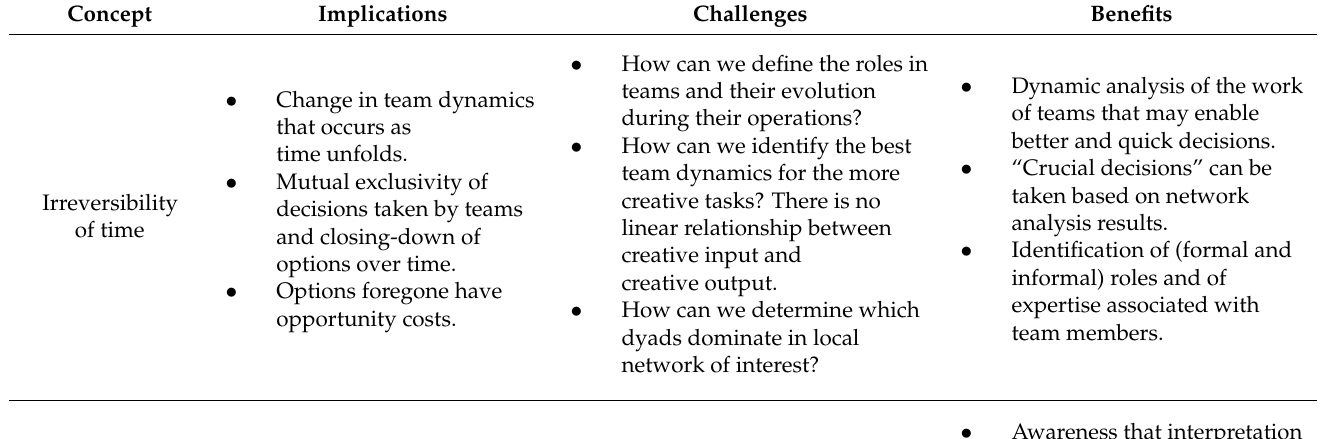
Table 1. Summary of implications, challenges, and benefits for teamwork from complexity science and network